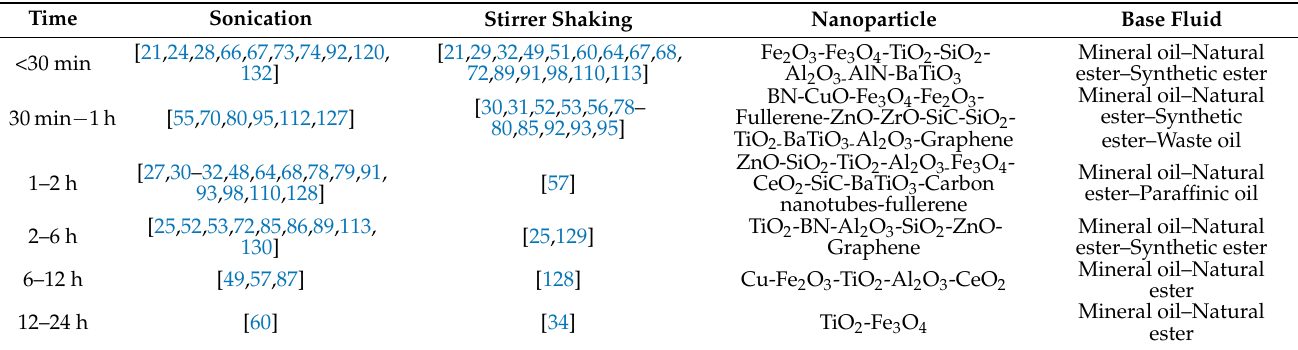
Table 10. Homogenization times during nanofluids